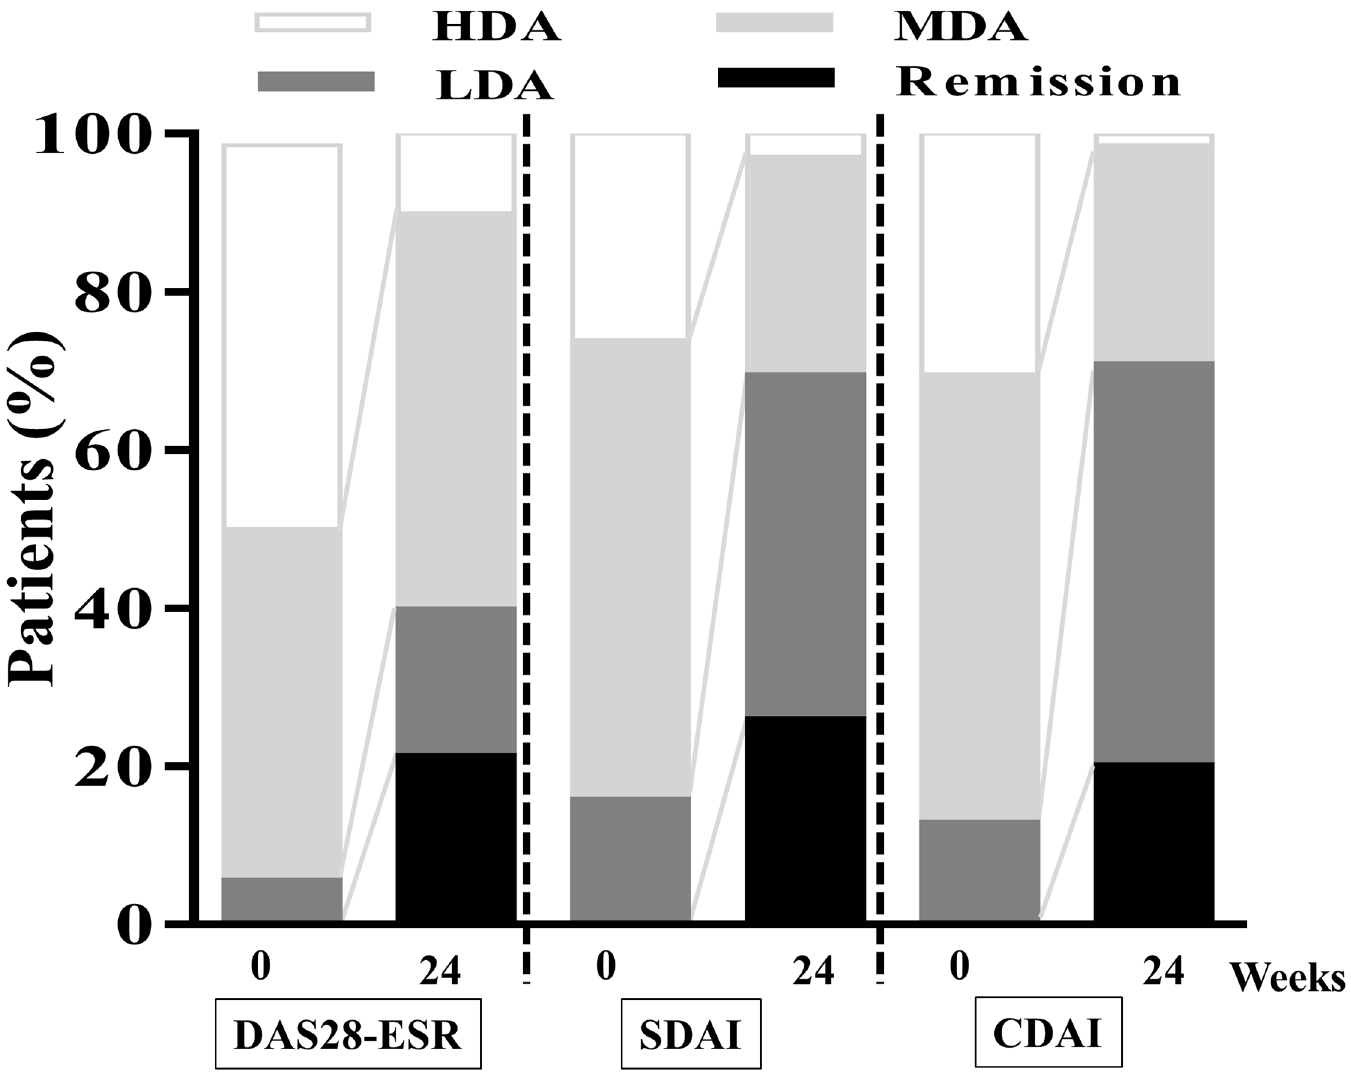
Fig 2. The proportion of disease activity at baseline and 24 weeks after initiation of tofacitinib treatment. Disease activity was categorized as follows: DAS 28-ESR < 2.6(remission), 2.6- (cid:20) 3.2(LDA), 3.2- (cid:20) 5.1(MDA), 5.1 < (HDA); SDAI < 3.3(remission), 3.3- < 11(LDA), 11- ≦ 26(MDA), 26 < (HDA); CDAI < 2.8 (remission), 2.8- < 10(LDA), 10- ≦ 22(MDA), 22 < (HDA); ESR erythrocyte sedimentation rate, DAS diseaseactivity score, SDAI simplifieddiseaseactivity index, CDAI clinicaldiseaseactivity index, LDA low disease activity, MDA moderate diseaseactivity, HDA high diseaseactivity.